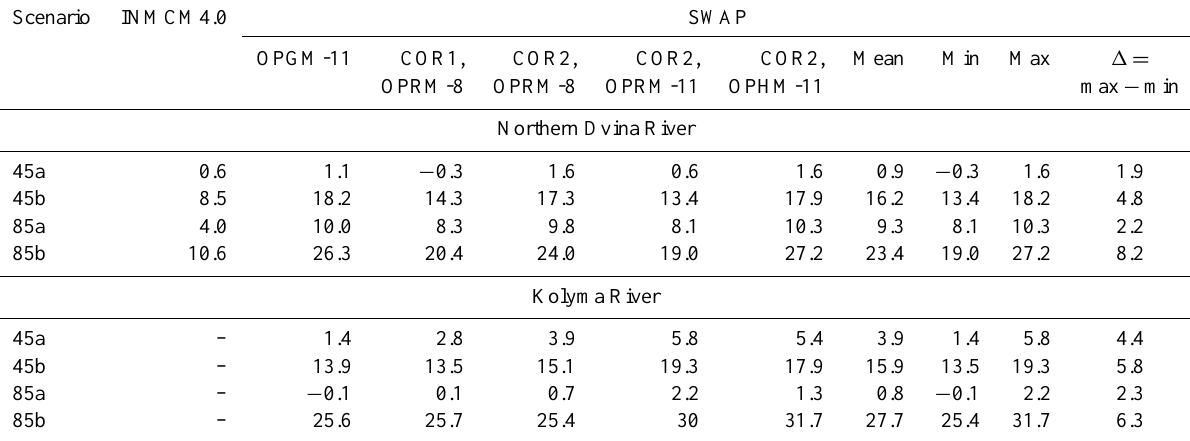
Table 2. Relative change in annual runoff (%) of the Northern Dvina and the Kolyma rivers obtained by the LSM SWAP with different sets of optimal parameters and different bias-correction techniques and by the AOGCM INMCM4.0. Mean, maximum and minimum values are given for the SWAP’s